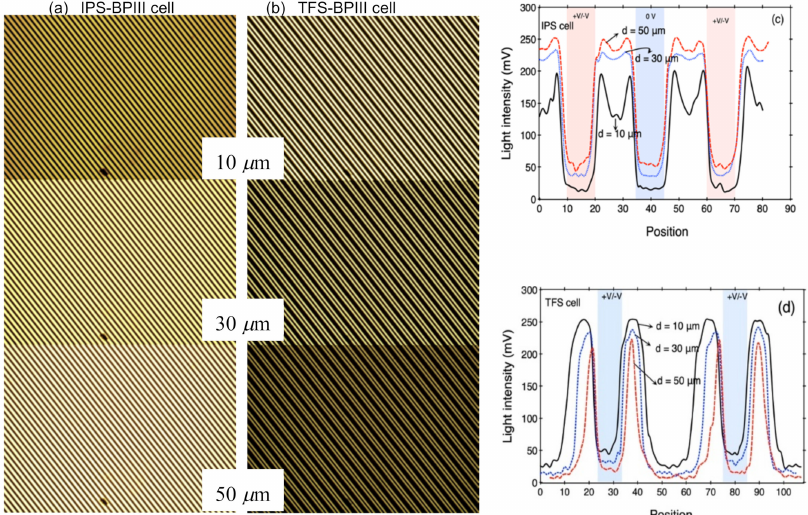
Figure 2. The microscopic pictures (10 × objective lens) of ( a ) the in-plane-switching (IPS)- and ( b ) TFS-BPIII cells with di ff erent cell gaps when 200 V is applied to them. We analyzed the intensity distributions of these ( c ) IPS- and ( d ) TFS-BPIII cells. The color strips in the figure indicate the